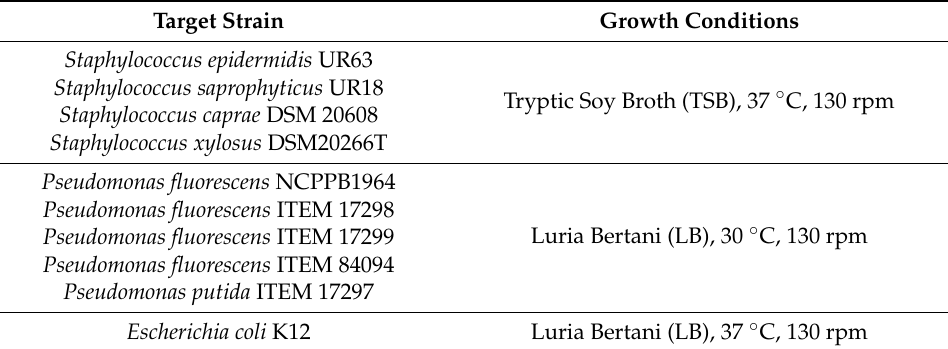
Table 1. Target strains, growth media and culture